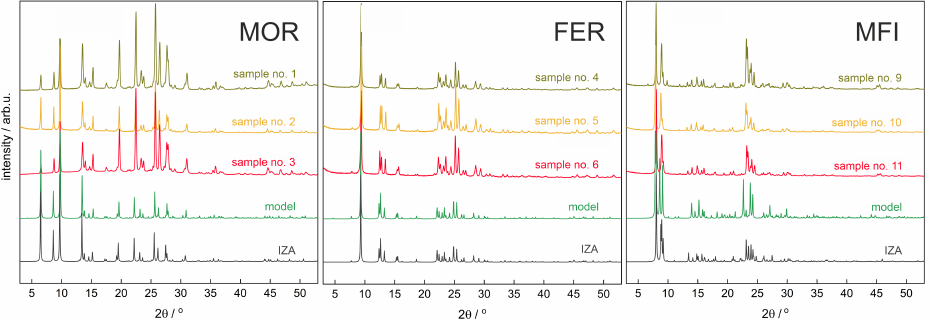
Figure 4. PXRD diffractograms of silicalite (IZA), studied samples, and computational models for MFI, MOR, and FER.